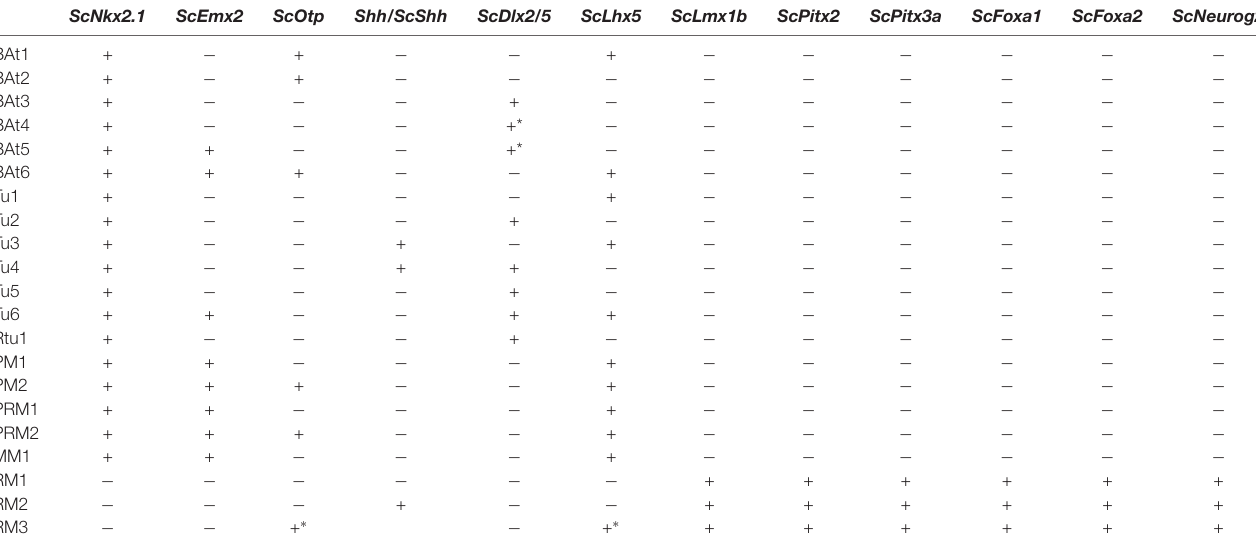
TABLE 1 | Microzone histogenetic codes of the shark basal hypothalamus corresponding to schemes in Figure 6 .